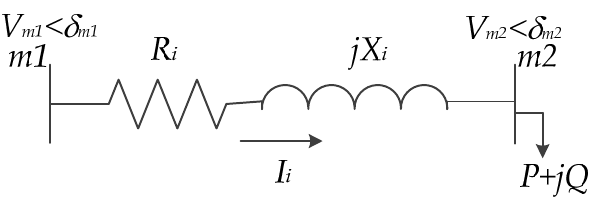
Figure 1. One-line diagram of the two-bus radial distribution system.